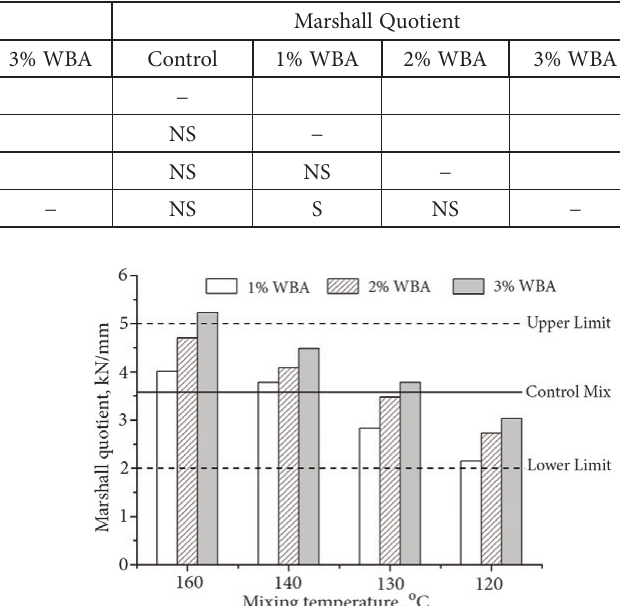
Table 8. Statistical analysis results of Marshall Stability and Marshall Quotient (irrespective of mixing temperature)